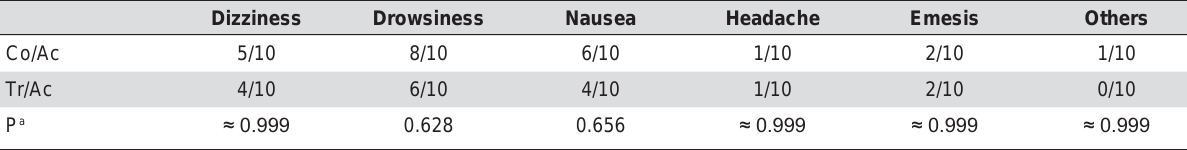
Figure 2- Graph of pain scores at each time point Table 3- (cid:3)(cid:55)(cid:75)(cid:72)(cid:3)(cid:73)(cid:85)(cid:72)(cid:84)(cid:88)(cid:72)(cid:81)(cid:70)(cid:92)(cid:3)(cid:82)(cid:73)(cid:3)(cid:68)(cid:71)(cid:89)(cid:72)(cid:85)(cid:86)(cid:72)(cid:3)(cid:85)(cid:72)(cid:68)(cid:70)(cid:87)(cid:76)(cid:82)(cid:81)(cid:86)(cid:3)(cid:85)(cid:72)(cid:83)(cid:82)(cid:85)(cid:87)(cid:72)(cid:71)(cid:3)(cid:71)(cid:88)(cid:85)(cid:76)(cid:81)(cid:74)(cid:3)(cid:87)(cid:75)(cid:72)(cid:3)(cid:88)(cid:86)(cid:72)(cid:3)(cid:82)(cid:73)(cid:3)(cid:70)(cid:82)(cid:71)(cid:72)(cid:76)(cid:81)(cid:72)(cid:3)(cid:68)(cid:81)(cid:71)(cid:3)(cid:68)(cid:70)(cid:72)(cid:87)(cid:68)(cid:80)(cid:76)(cid:81)(cid:82)(cid:83)(cid:75)(cid:72)(cid:81)(cid:3)(cid:70)(cid:82)(cid:80)(cid:69)(cid:76)(cid:81)(cid:68)(cid:87)(cid:76)(cid:82)(cid:81)(cid:3)(cid:11)(cid:38)(cid:82)(cid:18)(cid:36)(cid:70)(cid:12)(cid:3)(cid:68)(cid:81)(cid:71)(cid:3)(cid:87)(cid:85)(cid:68)(cid:80)(cid:68)(cid:71)(cid:82)(cid:79)(cid:3) and acetaminophen combination (Tr/Ac), expressed as the number of cases in relation to the sample size (n)